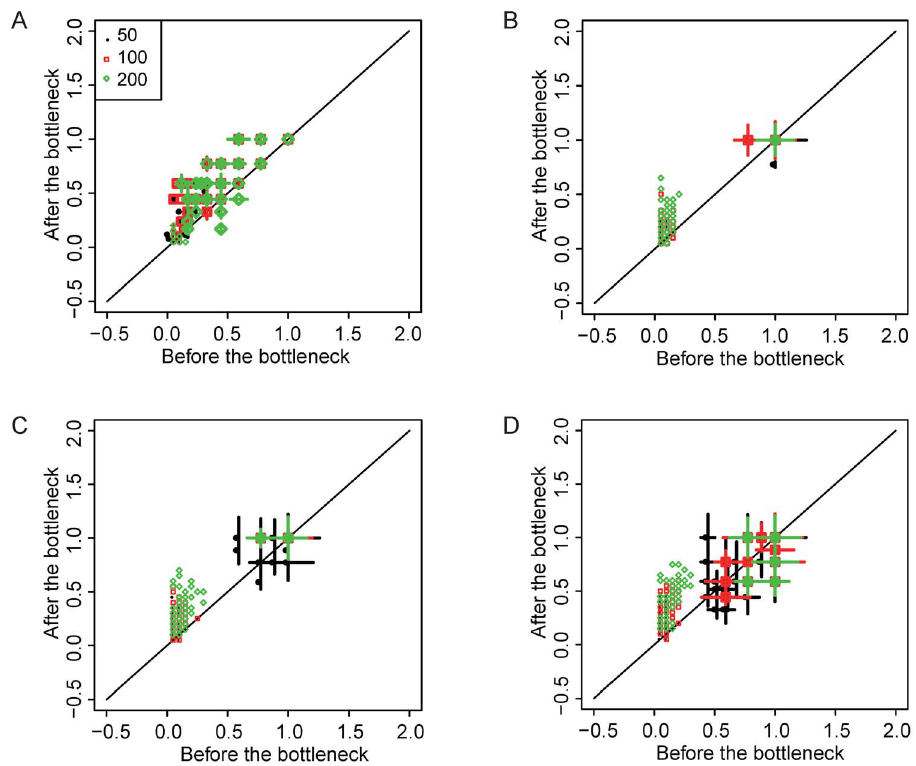
Fig. 4. Fitness gain and number of potential oncogene changes when subjected to type I population bottleneck. Each boxplots represents median and standard deviation of maximal fitness gain before and after the bottleneck for 50 simulation repeats. The dots represent the percentage of potential oncogenes before and after passing through the bottleneck (see main text for definition). Gene expression noise level is 0, population size is indicated in color, and mutation rates are A) 0.001, B) 0.05, C) 0.1and D)